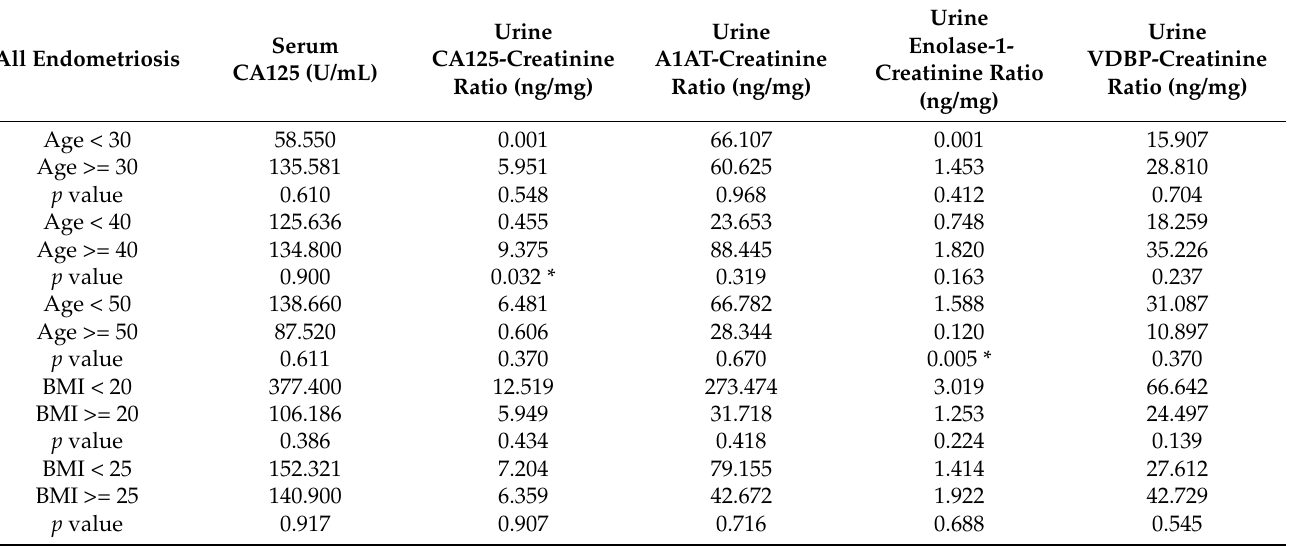
Table A2. The median values comparison of examined biomarkers in different subgroup analysis of parameters in all cohorts.